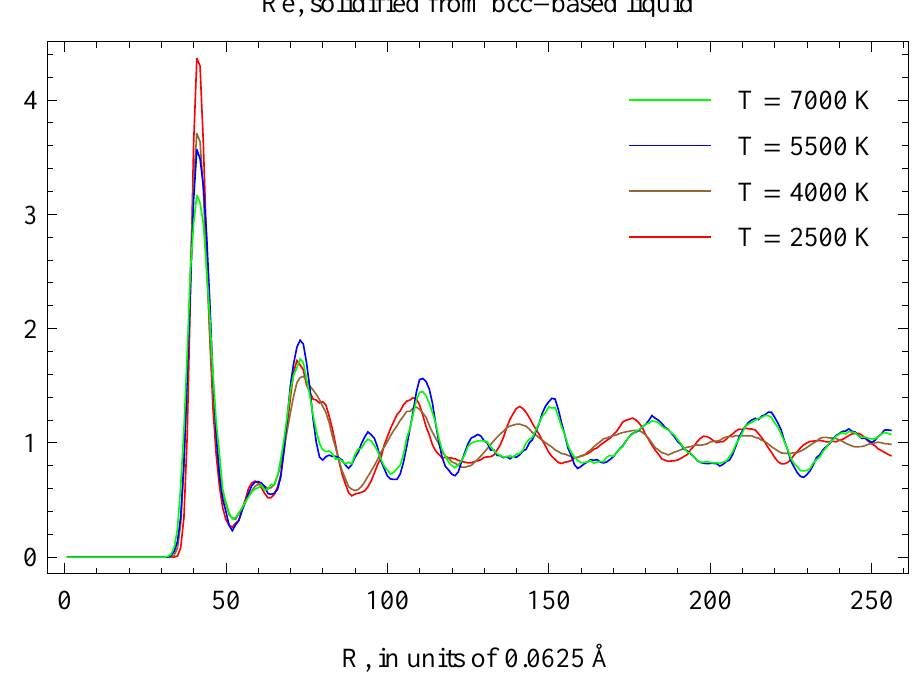
Figure 15. RDFs of the final states in the inverse Z simulations described in the text.